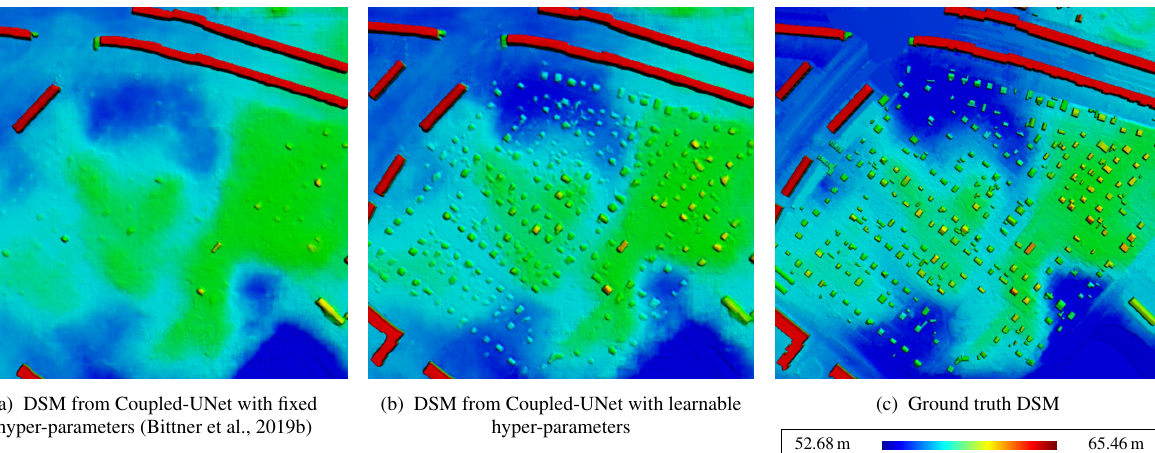
Figure 2. Visual analysis of DSMs, generated by Coupled-UNet cLSGAN with (a) fixed balancing hyper-parameters (Bittner et al., 2019b) and (b) learnable balancing hyper-parameters in comparison to (c) referenced surface model over selected urban area. DSM images are color-shaded for better